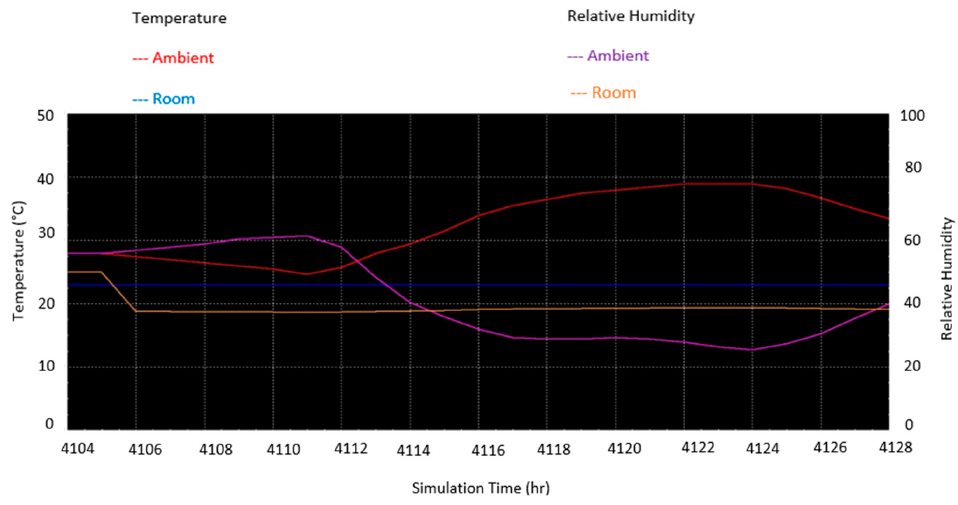
Figure 10. 1st June simulation run for configuration A.